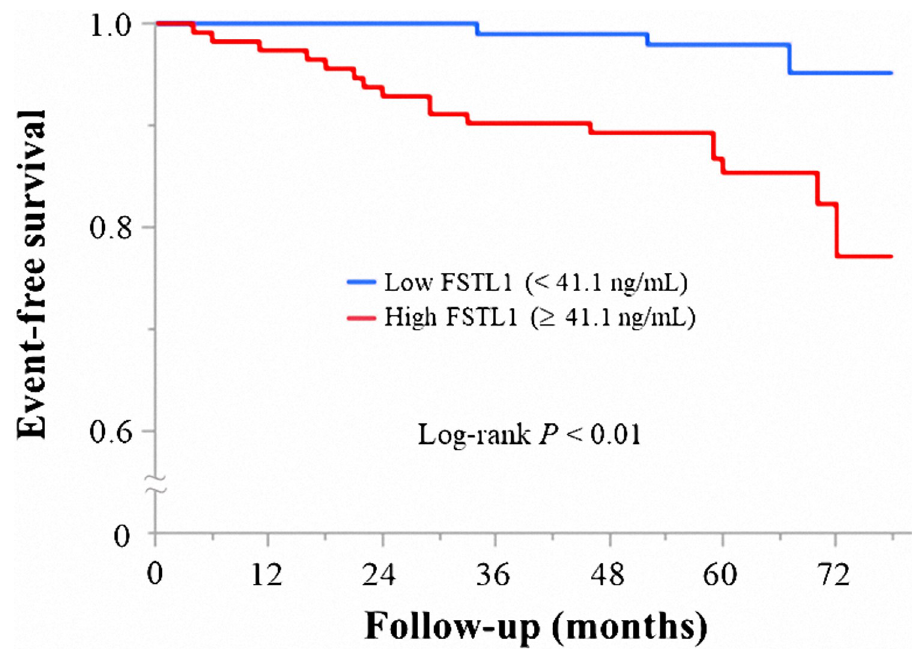
Fig 2. Event-free survival for MACCE. Kaplan–Meier analysis revealed that the MACCE rate was significantly higher in patients with FSTL1 ( � 41.1 ng/mL) than in those FSTL1 < 41.1 ng/mL ( P < 0.01). FSTL1, follistatin-like 1; MACCE, major adverse cardiac or cerebrovascular events.